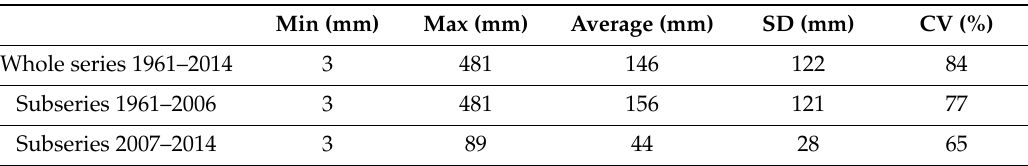
Table 3. Descriptive statistics of the series of annual precipitation values. SD: Standard Deviation, CV: Coe ffi cient of Variation, CA: Coe ffi cient of